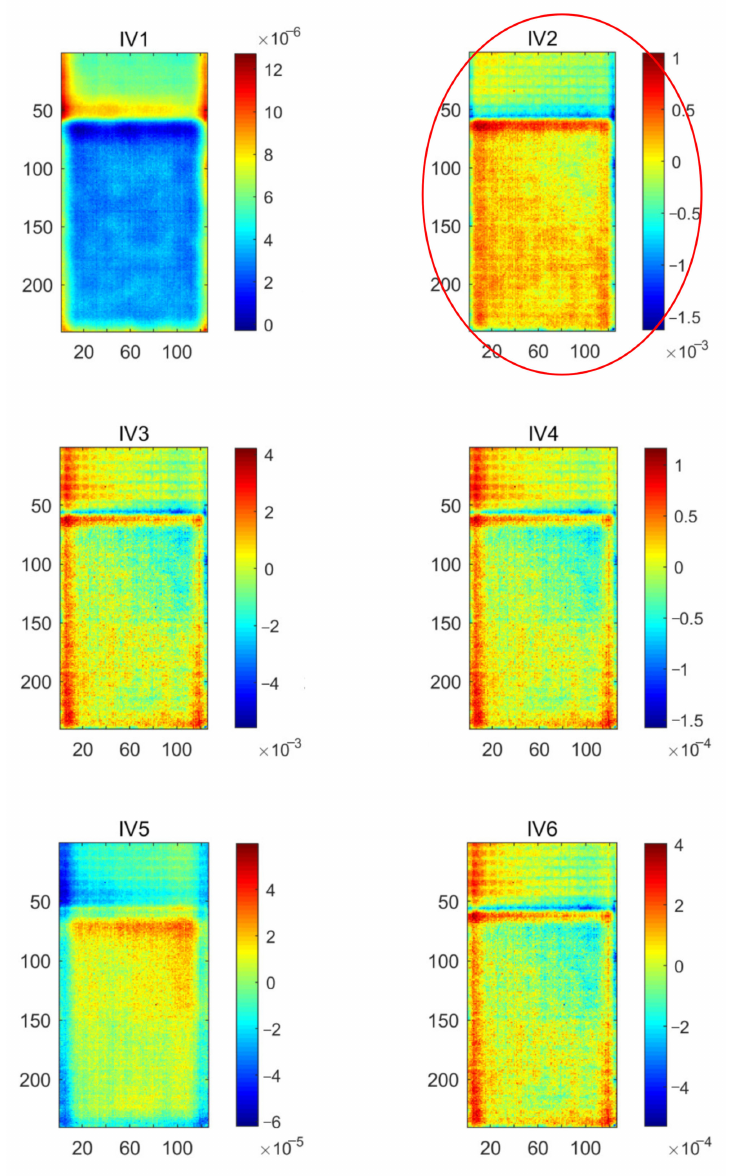
Figure 13. LTSA analysis